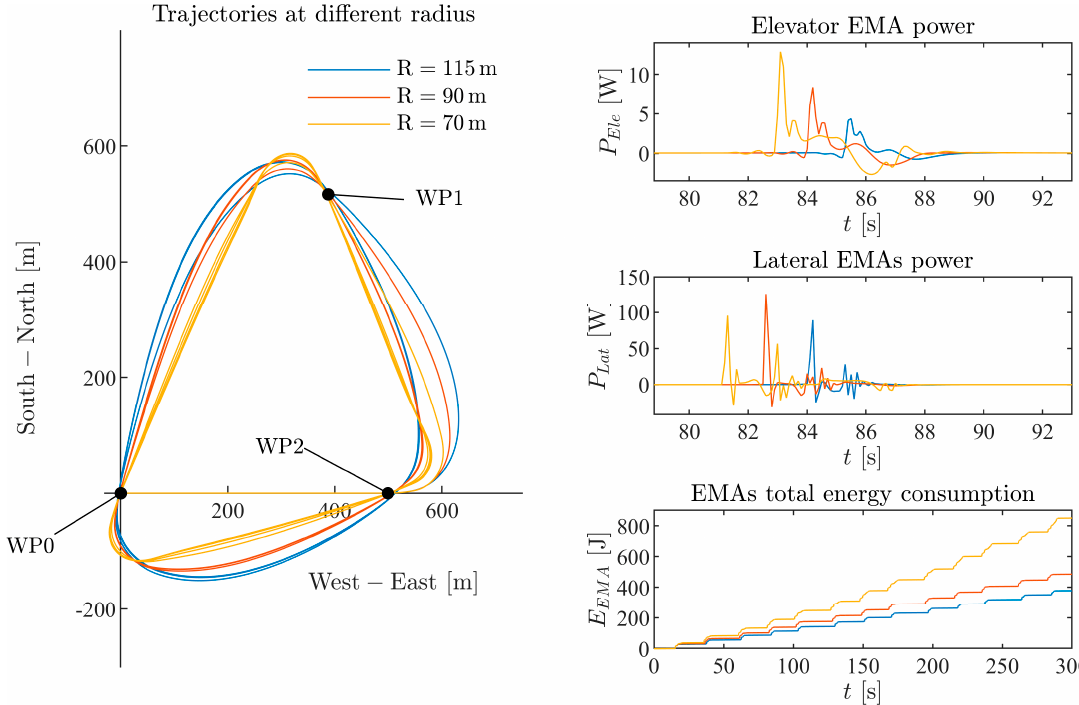
Figure 18. Trajectories and EMA power consumption at turning radii of 115 m, 90 m, and 70 m.